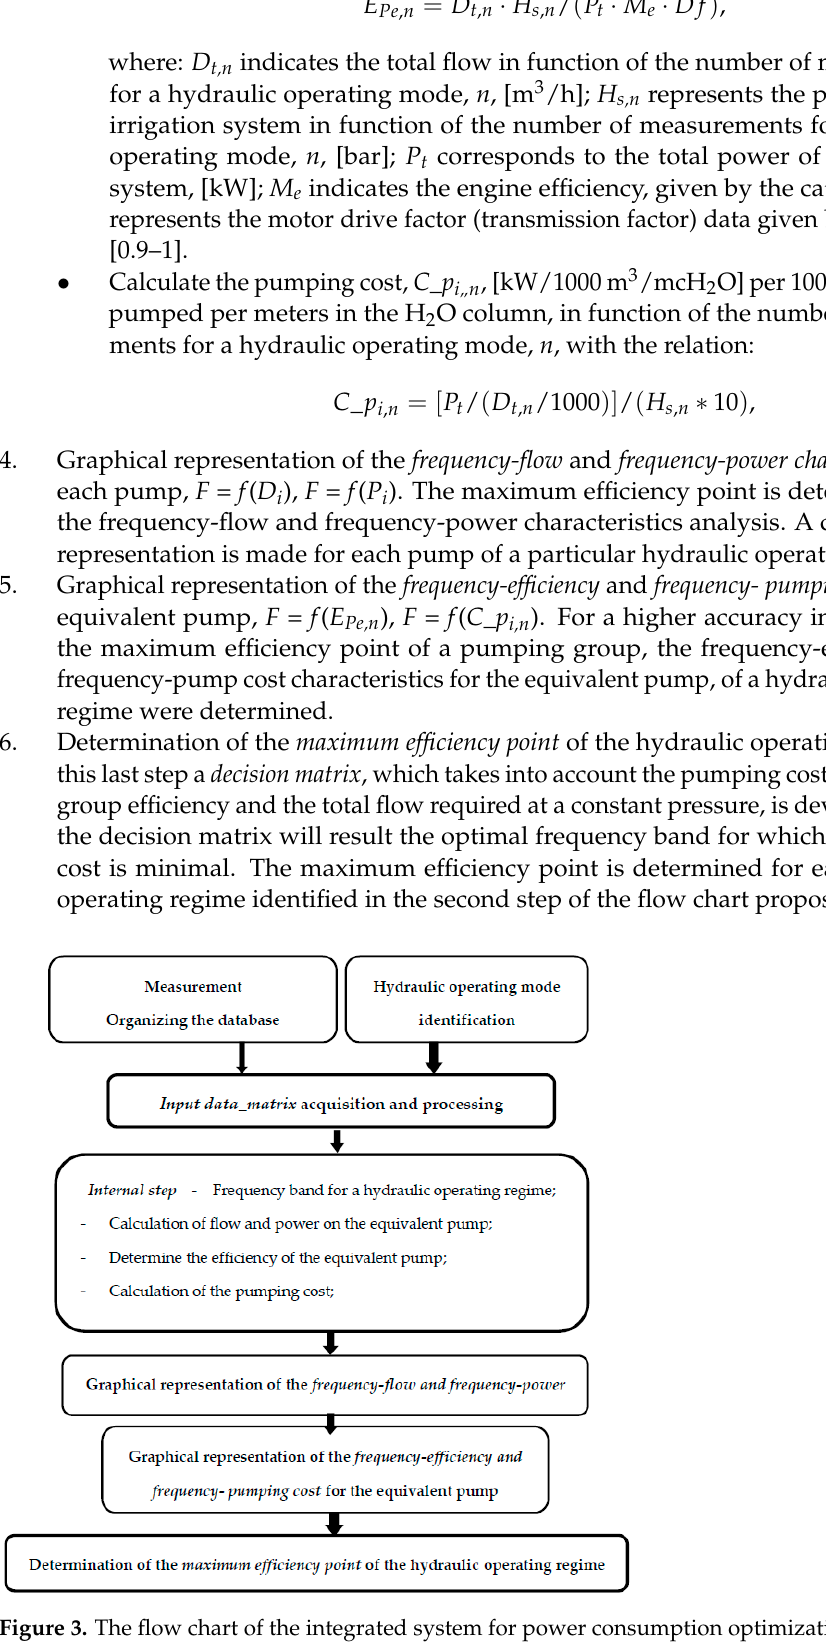
Figure 3. The flow chart of the integrated system for power consumption optimization.